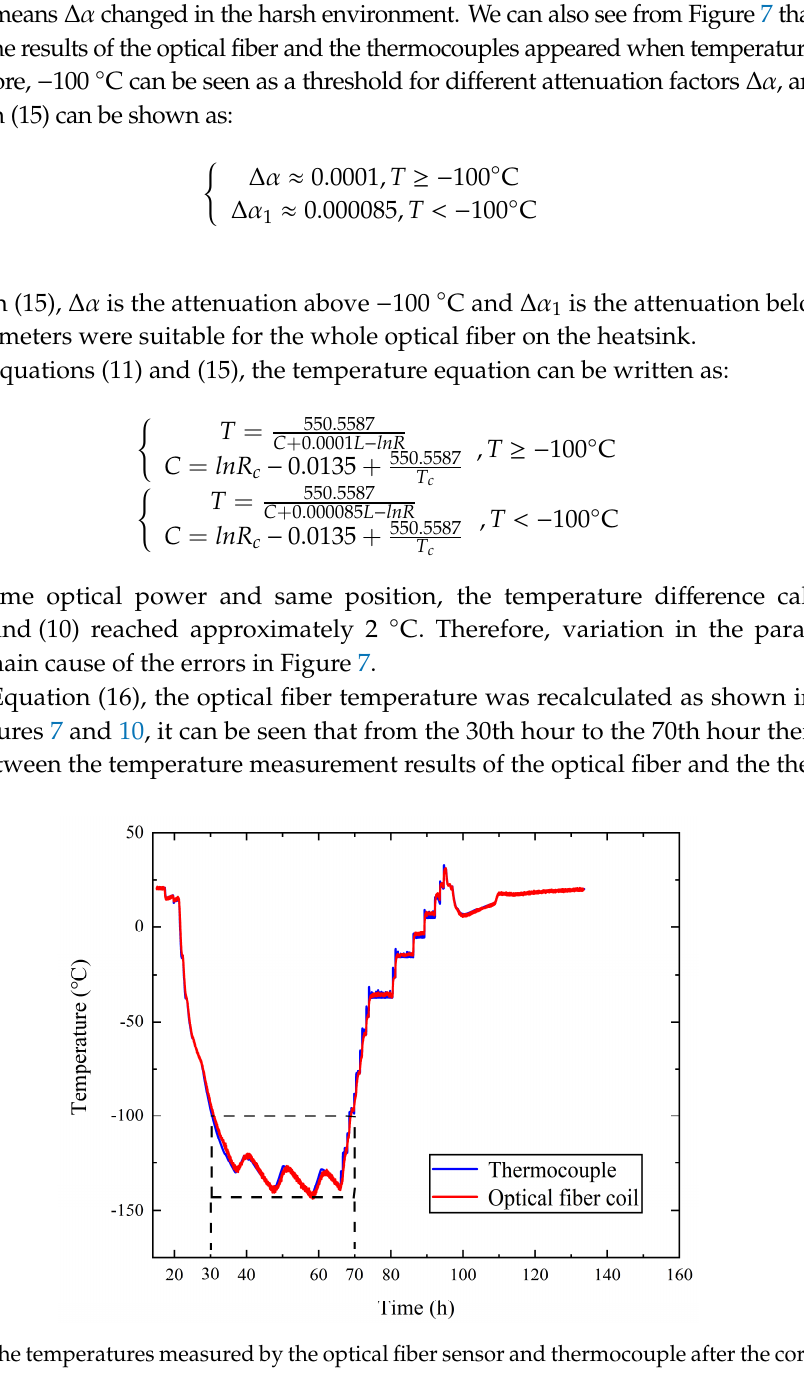
Figure 10. The temperatures measured by the optical fiber sensor and thermocouple after the